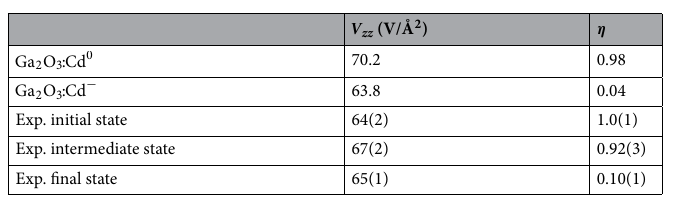
Table 1. V zz and η for each simulated Cd charge state and PAC experimental states. Experimental values of V zz were estimated from the experimental frequencies using the electric quadrupole moment Q = 0.765 ( 15 ) b 43